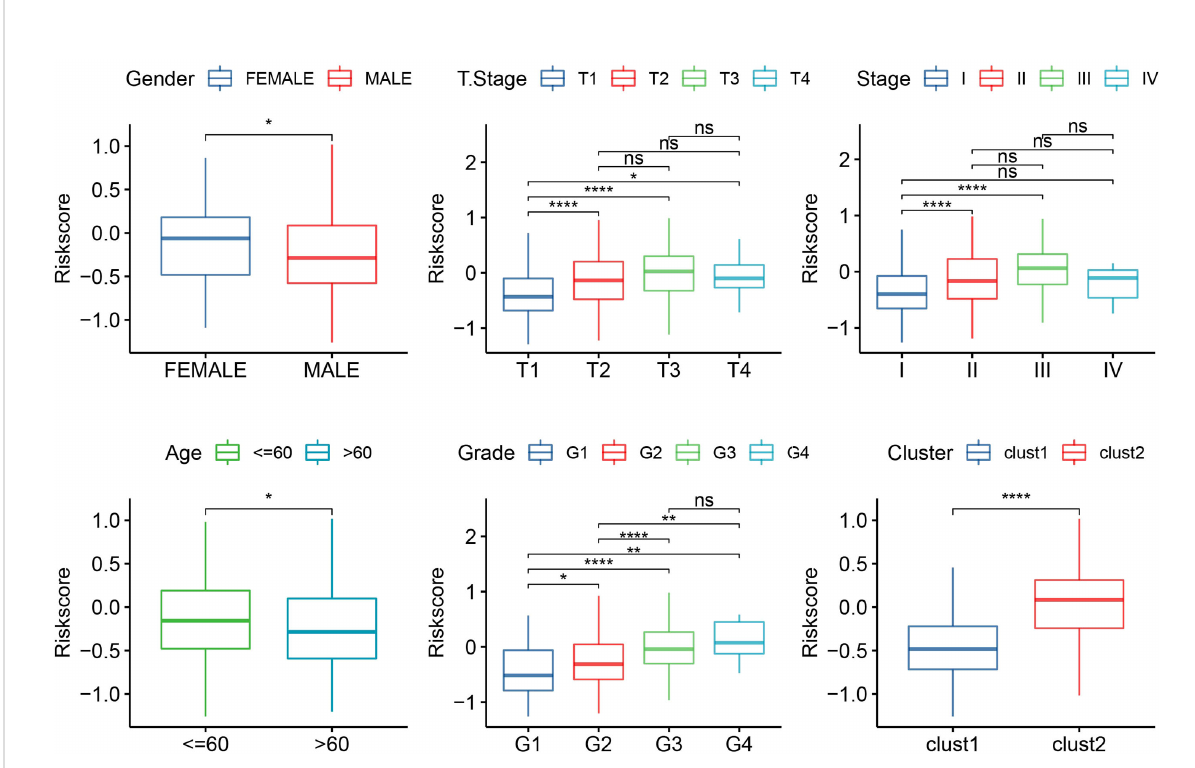
FIGURE 10 The RiskScore analysis in clinical features, including gender, T stage, stage, grade, age, and clusters. *p<0.05, **p<0.01, ****p<0.0001, ns, no signi fi